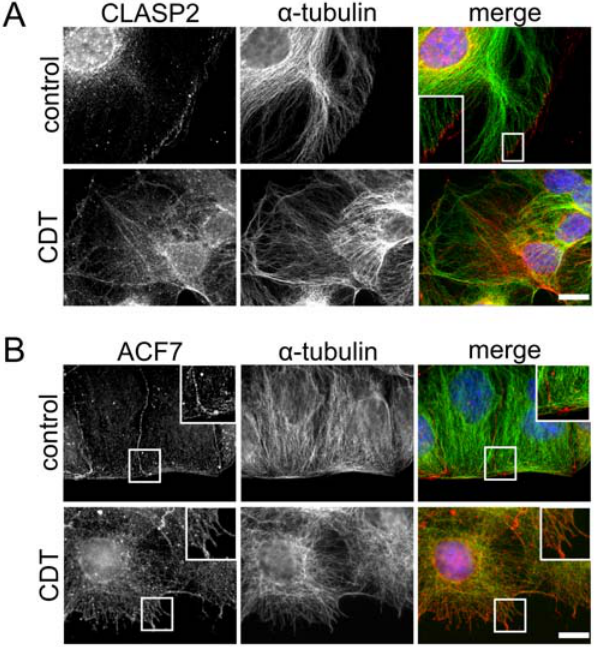
Figure 5. Influence of CDT on CLASP2 and ACF7 localization. ( A ) Indirect immunofluorescence of CLASP2 (red) and a -tubulin (green) in Caco-2 cells. The nucleus was stained by DAPI (blue). CLASP2 is translocated from the tip of microtubules that reached the cell cortex to filamentous structures in the cell interior. Cells were treated with 20 ng/ ml CDTa and 40 ng/ml CDTb and fixed after 2 h. Scale bar represents 20 m m. ( B ) Indirect immunofluorescence of ACF7 (red) and a -tubulin (green) in Caco-2 cells. The nucleus was stained by DAPI (blue). ACF7 is translocated from the cell cortex to the microtubule lattice in the cell interior. Cells were treated with 20 ng/ml CDTa and 40 ng/ml CDTb and fixed after 2 h. White squares represent magnifications. Scale bar represents 20 m m.